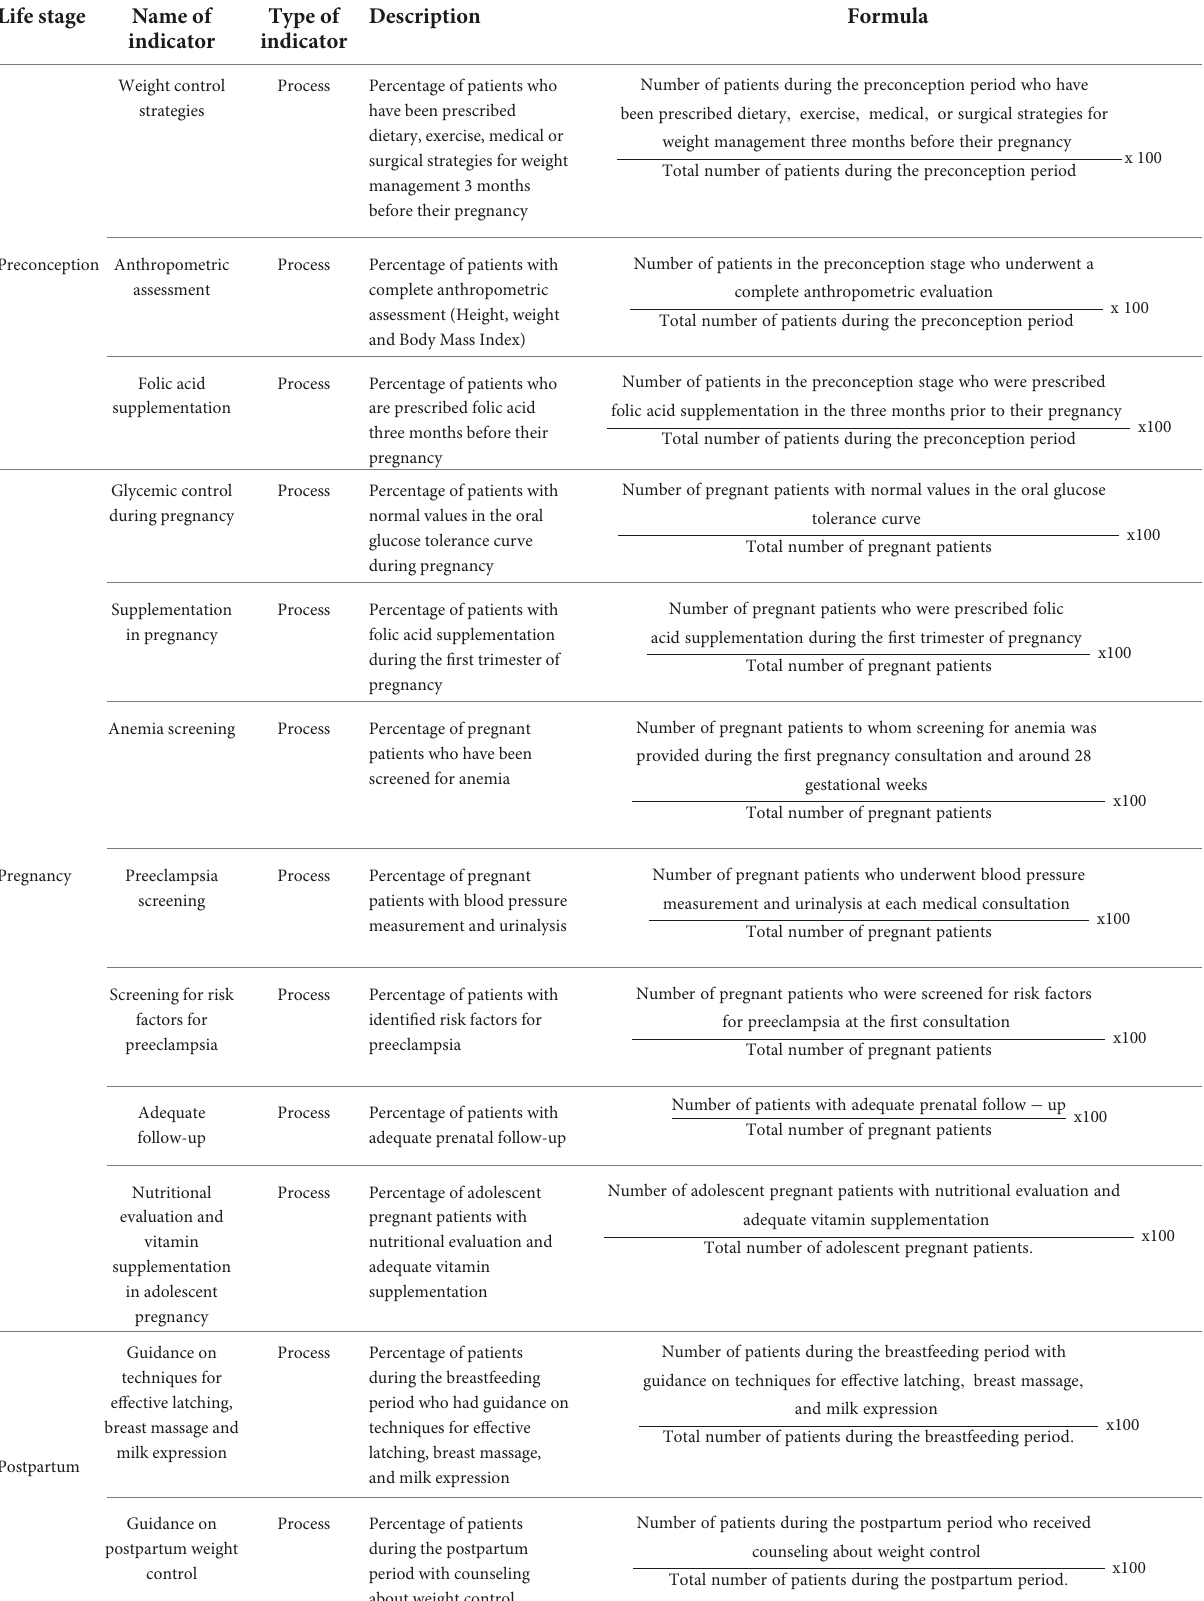
TABLE 2 Twenty two guideline-based indicators to assess the quality of maternal and child nutritional care at primary health